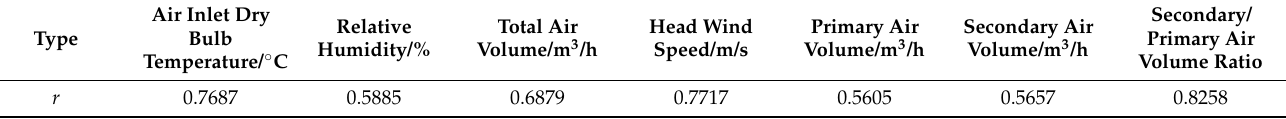
Table 4. Summary calculation results of the correlation degree of seven input